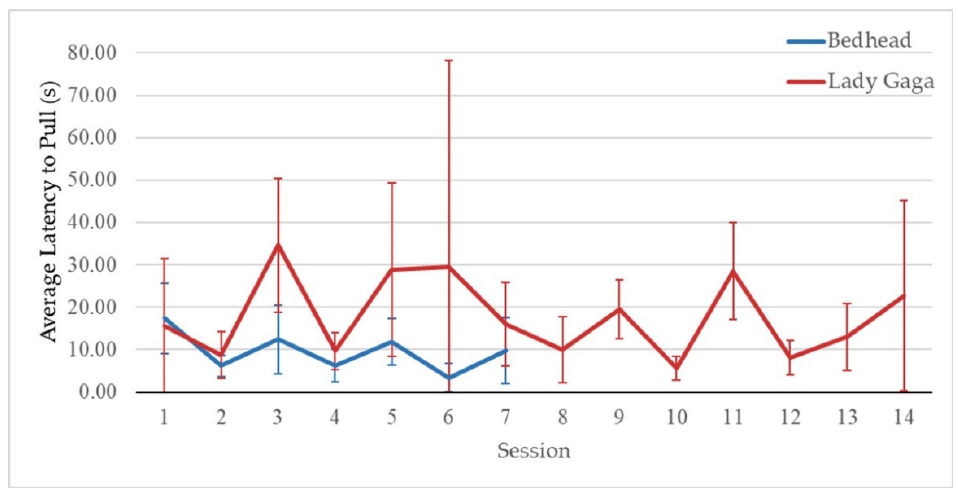
Figure 4. Average latency until first pull for each porcupine across sessions in Phase 1. Error bars depict standard deviations.